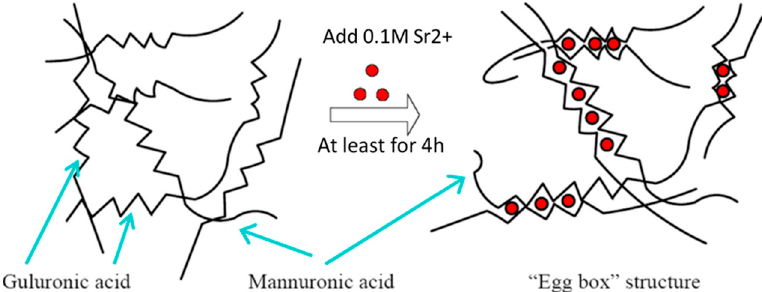
Figure 7. Curing of alginate hydrogel with the addition of strontium or calcium ions and the formation of an “Egg box“ structure. (Modified from Wan et